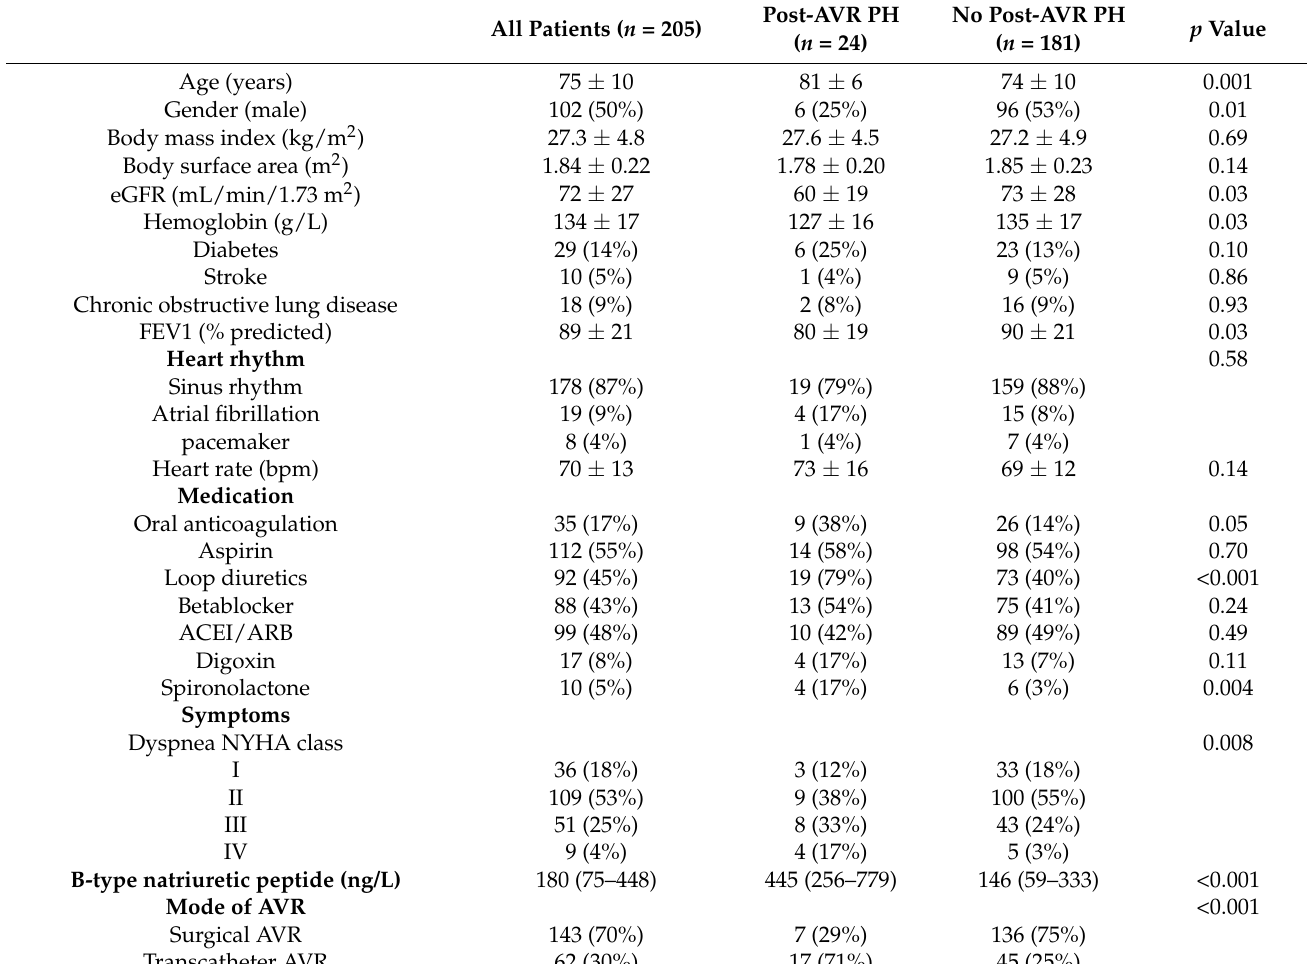
Table 1. Pre-aortic valve replacement clinical characteristics of the entire study population and patients with versus without pulmonary hypertension after aortic valve replacement (post-AVR